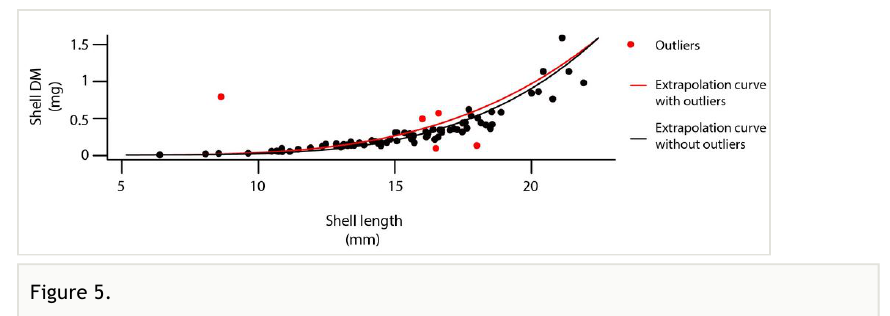
Data cleaning using extrapolation curves: an example of shell dry mass extrapolation based on shell length in the bivalve Macoma balthica